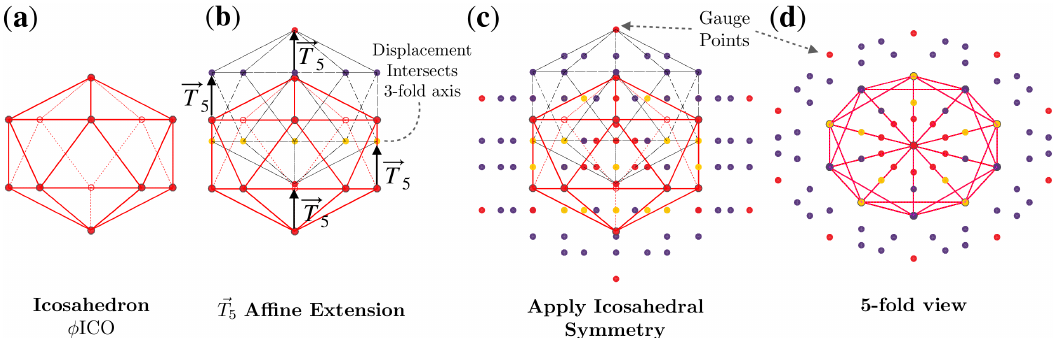
Figure 4. Formation of the φ ICO 5 point array [1]. ( a ) The base of this point array is an icosahedron scaled up by multiplying by φ . ( b ) The base point array is then translated by (cid:126) T 5 . Under this (cid:126) T 5 extension, the base point array consists of 4 separate levels. The lowest level is a single vertex which remains on the 5-fold axes, the next level of 5 vertices all intersect 3-fold axes (all with the same radius). The next level is located on the 5-2 great circle of the AU, resulting in 60 points. Finally, the gauge point of the point array is created by the largest radius point (Figure 5). ( c ) Icosahedral symmetry is now applied, creating the full point array (base and cloud), where the points are colored as in Figure 1. As the translation was (cid:126) T 5 , the resulting gauge point remains on the 5-fold axes (Figure 1). ( d ) A look down one of the twelve 5-fold axes shows that the point array has icosahedral symmetry. This entire point is enveloped by a now larger icosahedron, with the purple points sitting on its edges. The formation of point arrays can equivalently be described as placing an icosahedron centered at each of the original base vertices to create the point cloud.